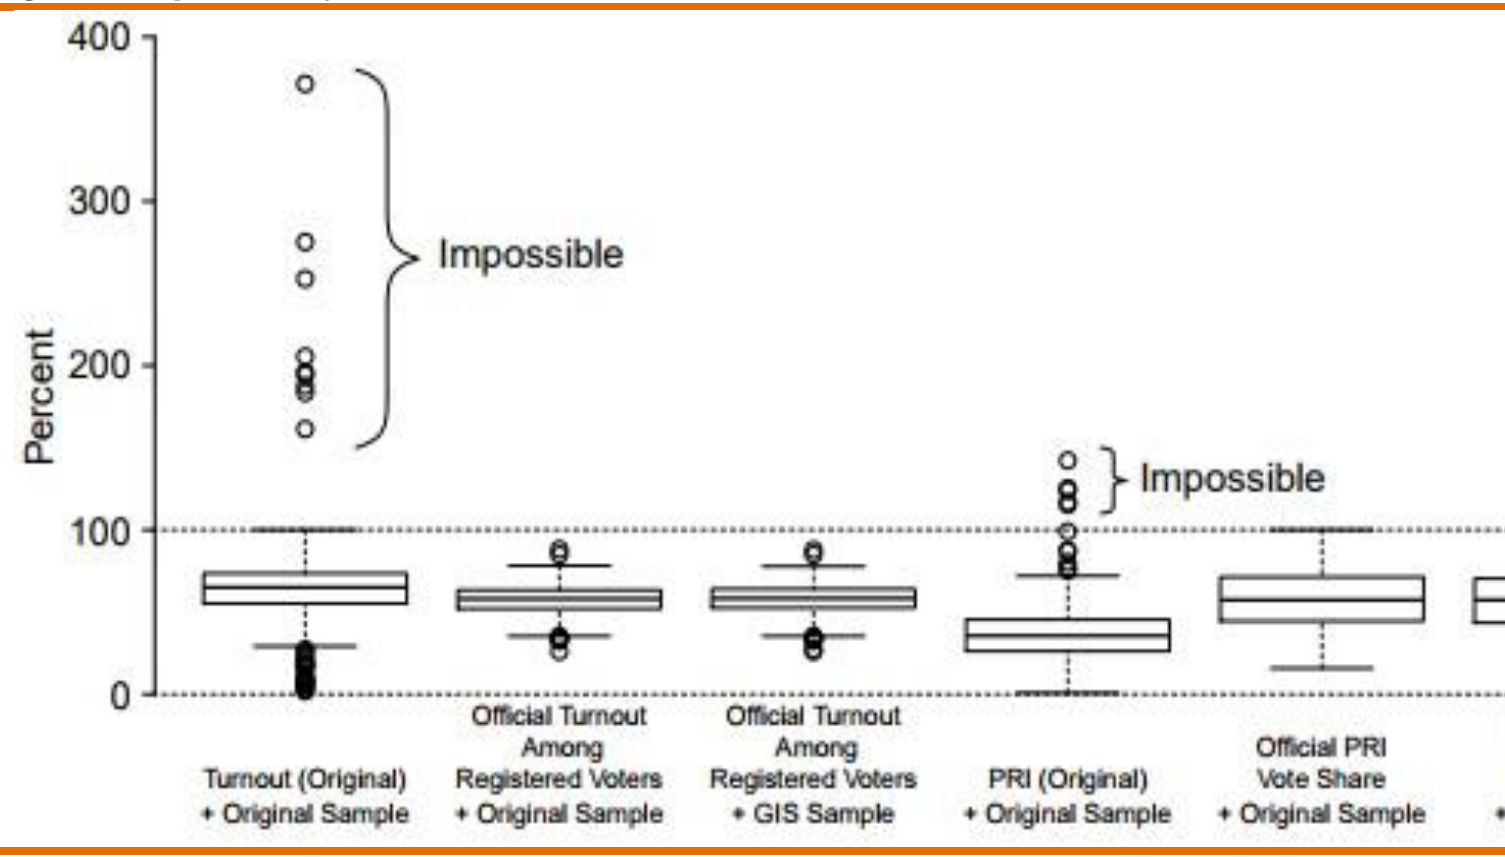
Figure 02. Reproducibility and outlier issues